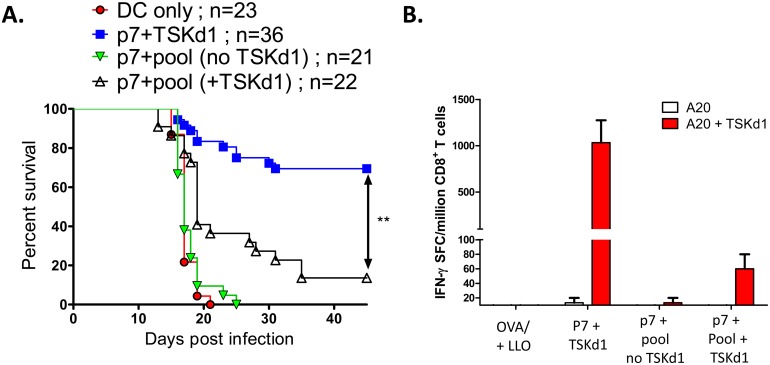
The WT TS vaccine-induced subdominant epitope responses are counterproductive for host immunity.B16-Flt3L-induced and in vivo LPS matured CD11c+ dendritic cells were pulsed with TS peptides and injected i.v. into groups of naïve BALB/c mice (1x106 DC, twice, 2 weeks apart). The peptide pool was comprised of the panel of Kd, Dd, and Ld-restricted epitopes differentially induced by WT TS and TSKd1 null TS vaccination (TS peptides Kd2, Kd5, Kd6, Kd7, Kd9, Ld1, and Dd2). Groups of control DC (no peptide) and TS peptide-pulsed DC vaccinated mice were challenged 4 weeks later with 5,000 T. cruzi BFT and survival monitored (A). Mice vaccinated with p7 + TSKd1 alone were significantly more protected than mice vaccinated with p7 + pool (+ TSKd1) by Log-Rank [Mantel-Cox] Test, p<0.0001. Shown are cumulative results from multiple independent experiments. In addition, CD8+ T cells from representative vaccinated mice harvested pre-challenge (one month following the final DC immunization) were stimulated in IFN-γ ELISPOT assays with APC (A20) pulsed with the immunodominant TSKd1 peptide (B).